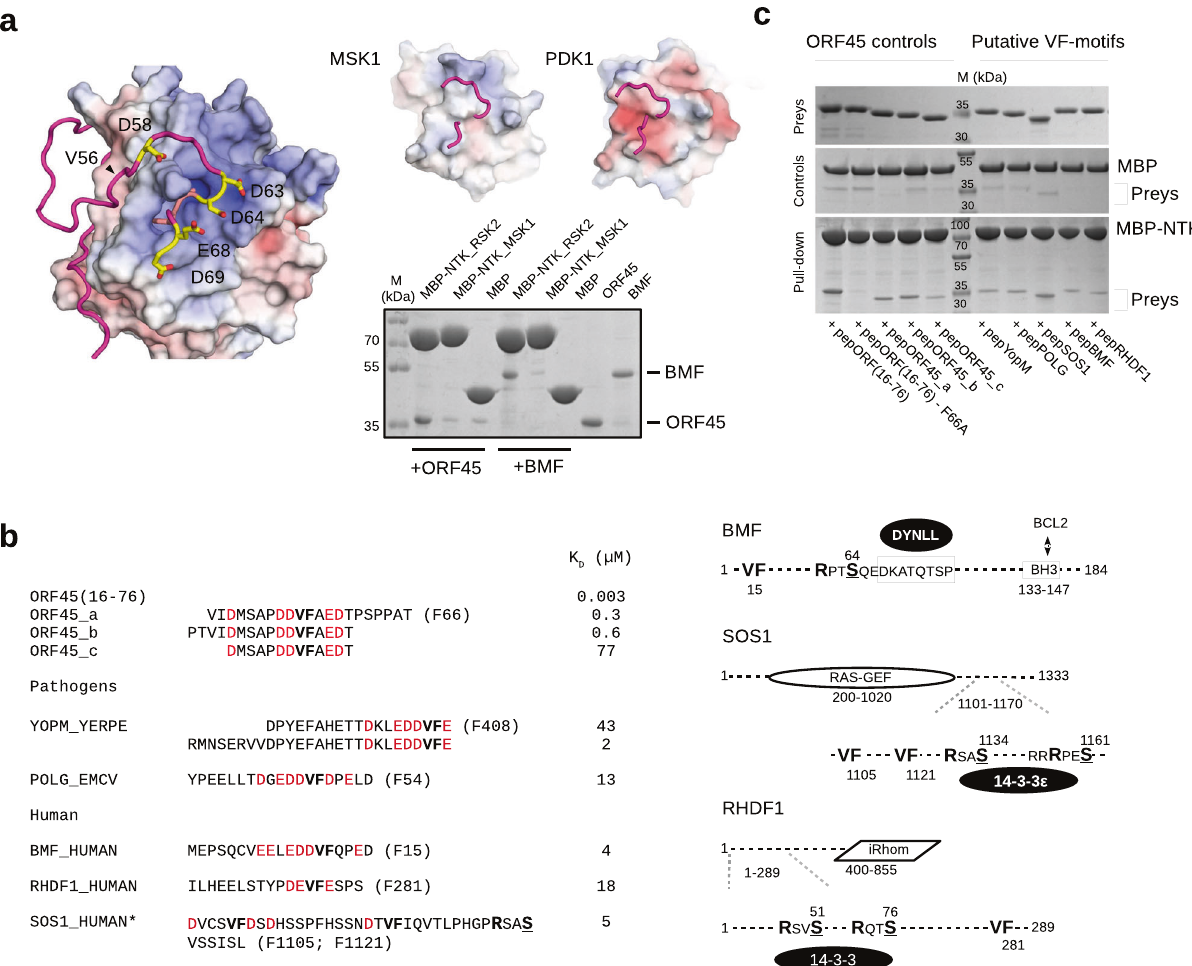
289) were expressed, puri fi ed, and used as substrates with activated RSK2 in kinase assays (Fig. 8a). These experiments clearly indicated an important role for VF-motif-based docking in RSK mediated the presence of ORF45, but the phosphorylation of the VF-motif independent EIF4B RxxS/T site remained unchanged.